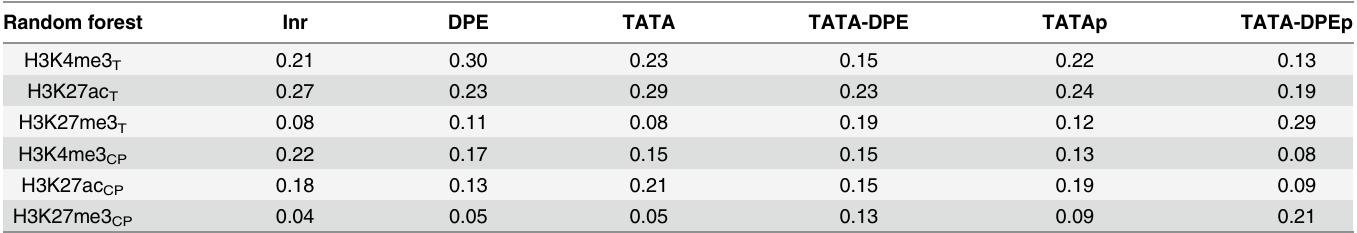
Table 2. The variable importance of each histone modification in determining RNA expression levels was obtained by random forest as mean decrease in node impurity. The matrices were normalized such that their sum was 1. Random forest Inr DPE